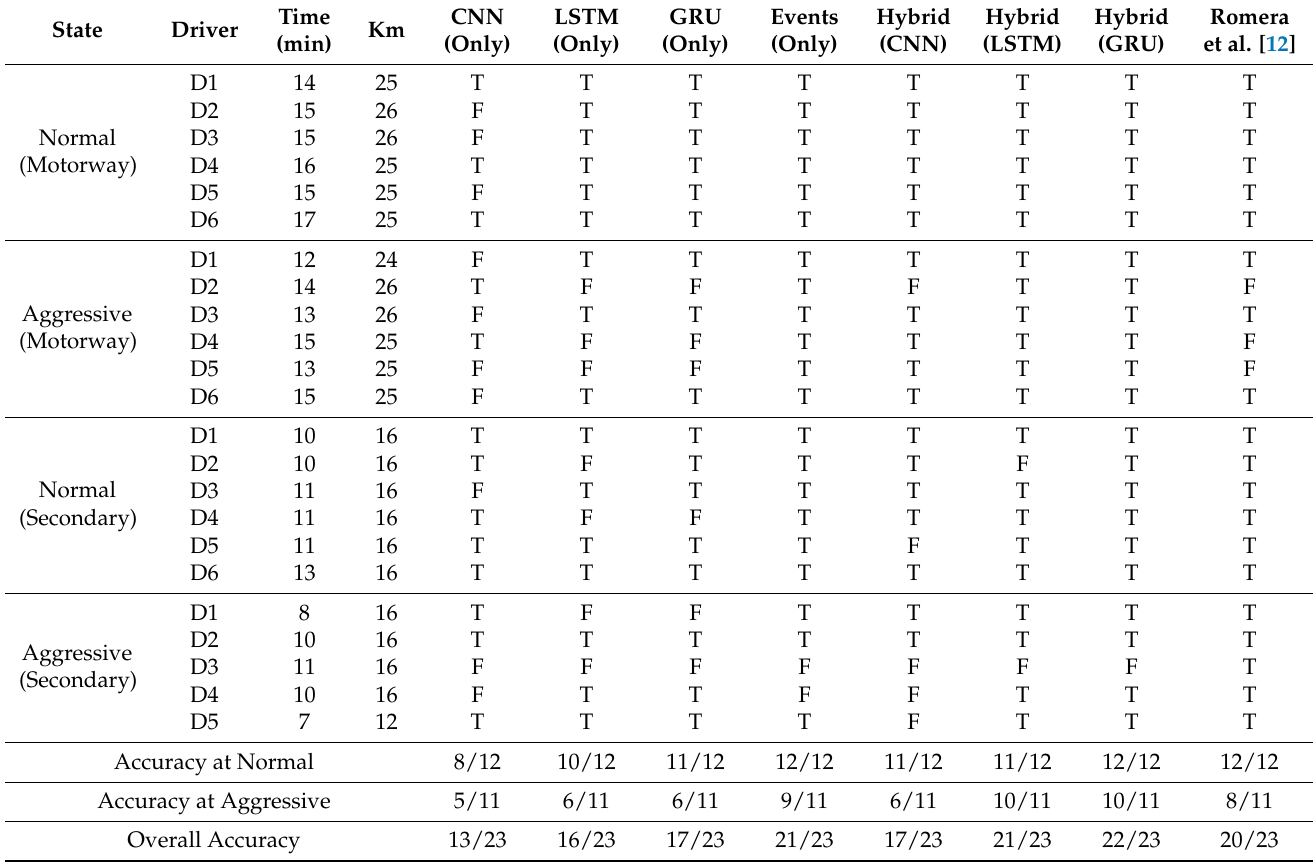
Table 7. Route level classification on UAH